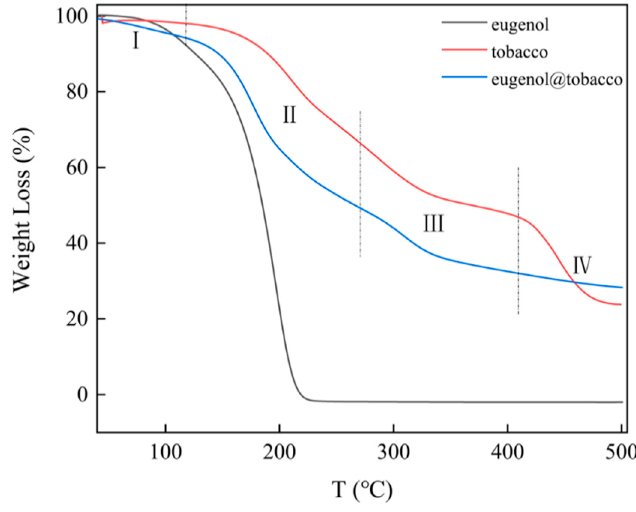
Figure 4. Thermal gravity analysis of eugenol, tobacco and tobacco leaf loaded with eugenol.